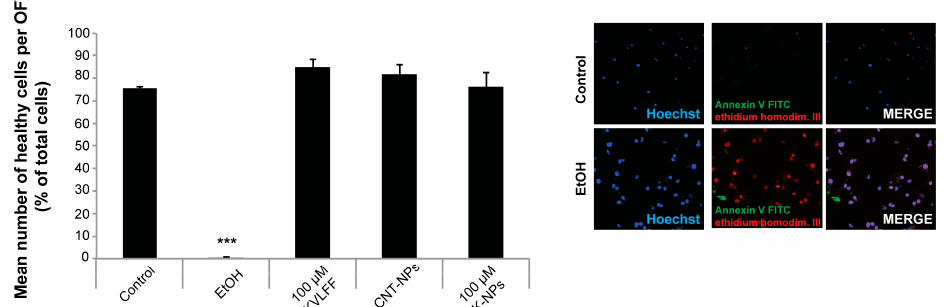
Figure 3. NPs delivering an equivalent of 100 µM KLVFF peptides are non-toxic for neurons. Toxicity profile of ethanol (positive control), CNT-NPs, 100 µM free KLVFF peptide, and NPs delivering 100 µM KLVFF peptide. Neuronal cells were treated for 24 h and compared to untreated control. Apoptotic cells were identified using Annexin V labeled with FITC (Fluorescein isothiocyanate), necrotic cells by ethidium homodimer III, and the total number of cells was assessed using Hoechst 33342, labeling all nuclei. A total of three optic fields of view per condition was analyzed. No significant effect of any treatment except ethanol was found for neuronal cell health (one-way ANOVA followed by Tukey test). Exemplary images for Control and positive Control (EtOH) is shown in the right panel.